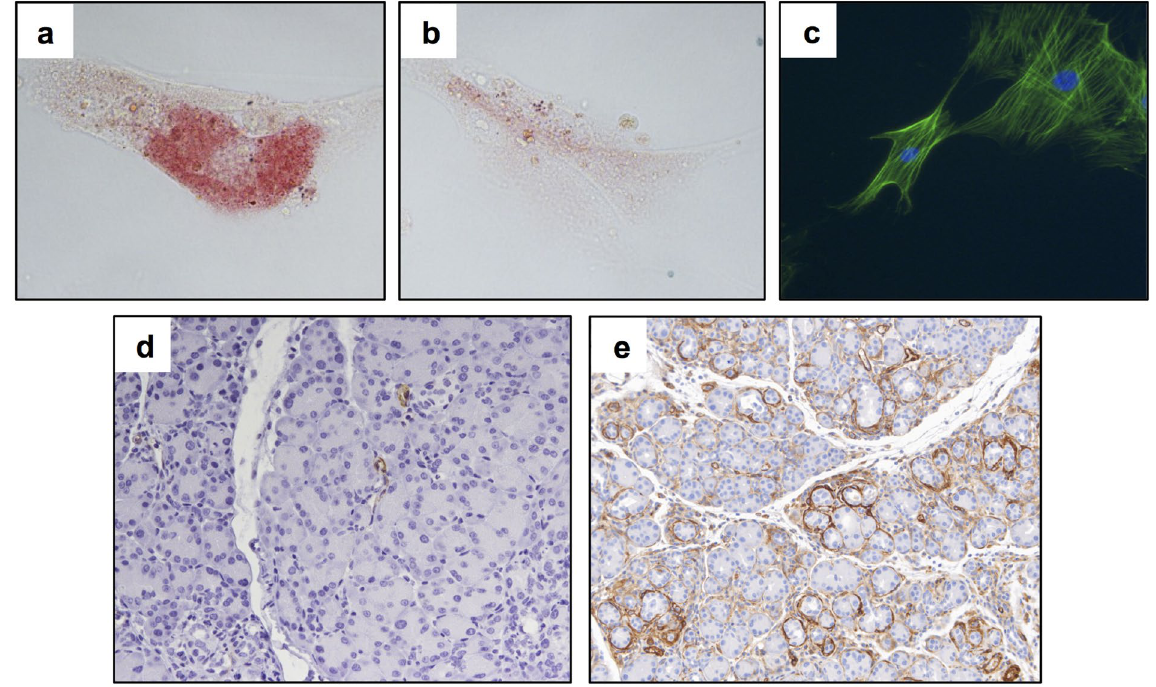
Figure 1. PSC display an activated phenotype in culture and in a murine model of CP. PaSC were treated with (a) 10 μ M all-trans retinoic acid (ATRA) or (b) vehicle control for 48 hours and stained for Oil-Red O. Cells were analyzed by light microscopy at 40X magnification. (c) Untreated PaSC were stained for α -SMA (green) by fluorescent microscopy following 48 hours of incubation (DAPI counterstain, 40X magnification). (d) Formalin fixed paraffin embedded (FFPE) pancreatic tissue from mice with caerulein-induced pancreatitis after (d) 1 week and (e) 5 weeks of treatment were stained for α -SMA (20X magnification). Representative images from n = 5 mice per